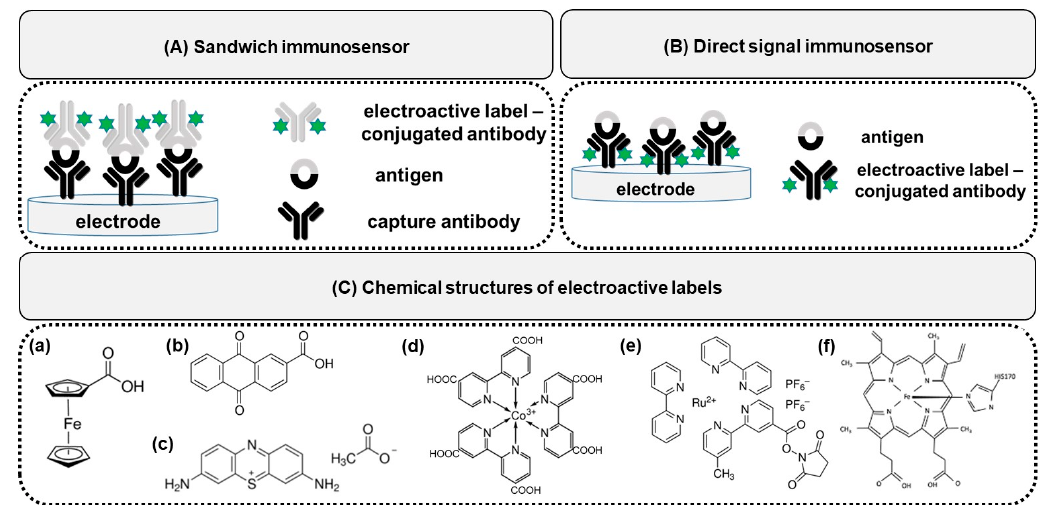
Figure 1. General scheme of immunosensor based on electroactive label conjugates: ( A ) in sandwich format; ( B ) in direct signal format; ( C ) chemical structures of different electroactive labels widely used for antibody bioconjugation: ( a ) ferrocenecarboxylic acid, ( b ) anthraquion-one 2-carboxylic acid, ( c ) thionine, ( d ) tris(2,2`-bipyridine-4,4`-dicarboxylic acid)cobalt(III), ( e ) tris(bipyridine)ruthenium(II) with N-succinimidyl ester group, ( f ) iron heme group in horseradish peroxidase.